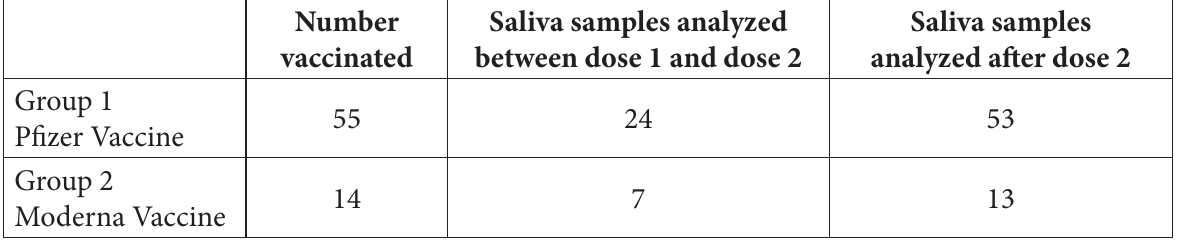
Table 1. Saliva samples successfully processed from NYP-WELCOME cohort